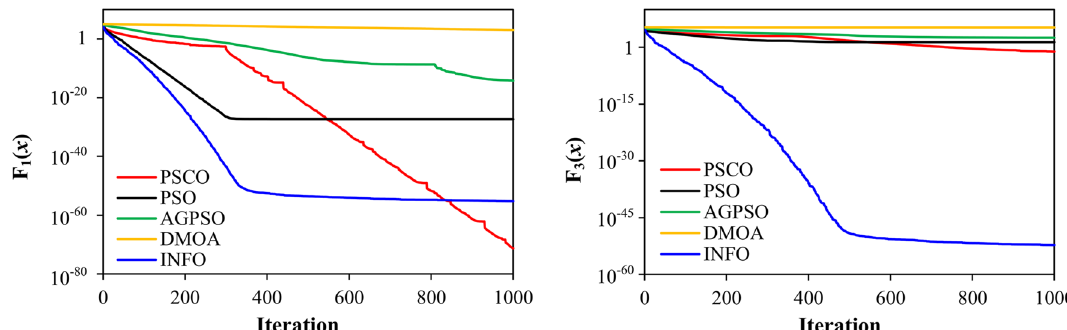
Fig. 3 The convergence rate for unimodal functions, D